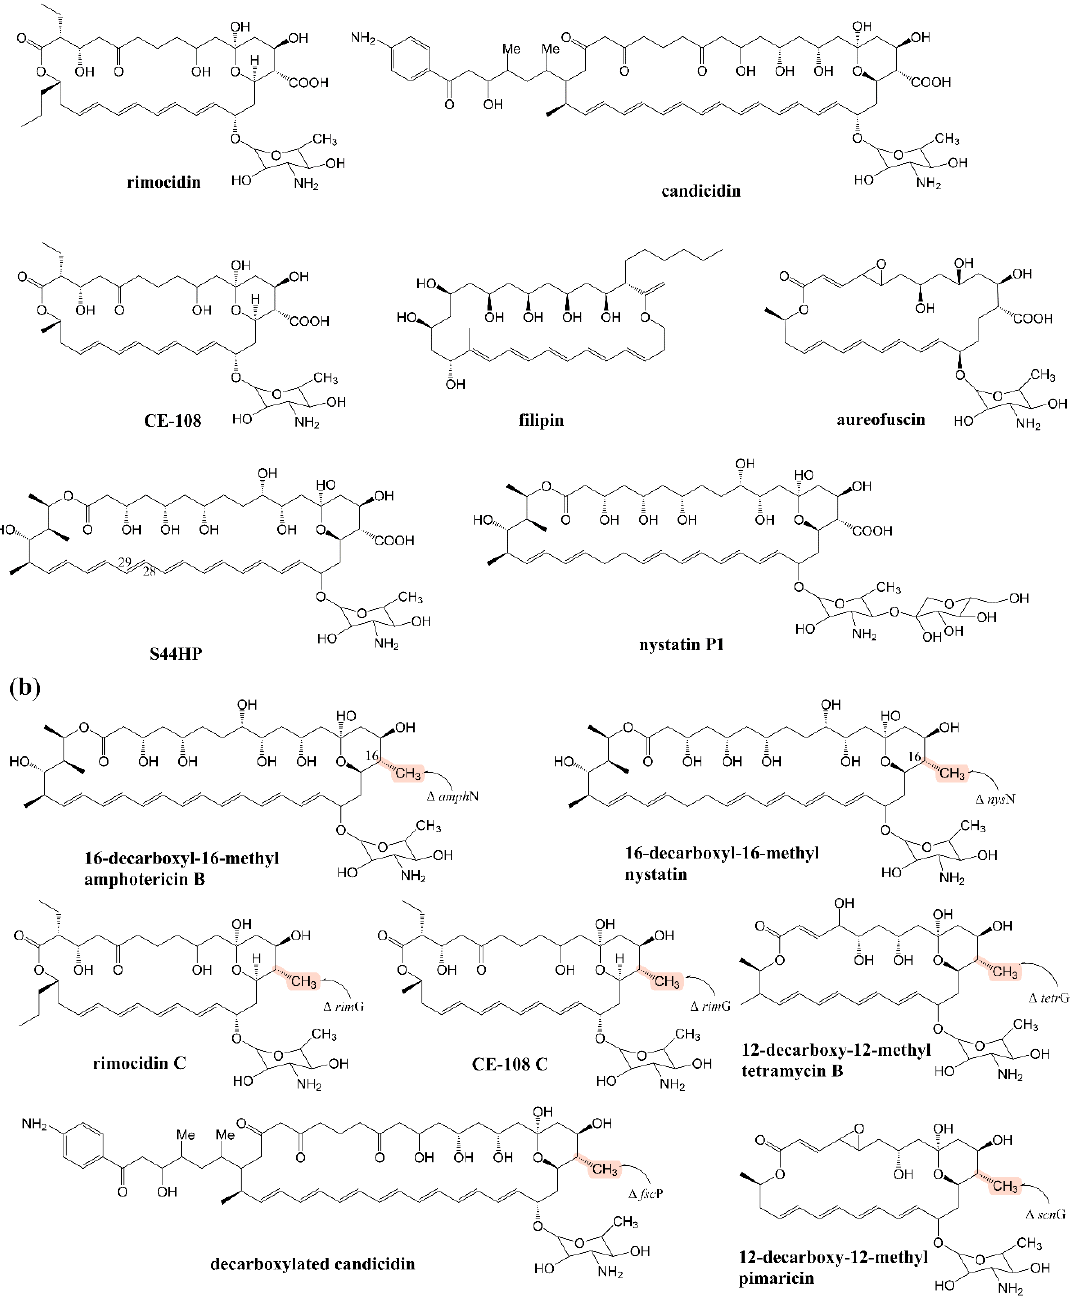
Figure 1. Structures of polyene macrolides and they derivatives. ( a ) Initial polyene for structural modification. ( b ) Polyene related to the modification of the carboxyl group, a derivative C2 ′ -